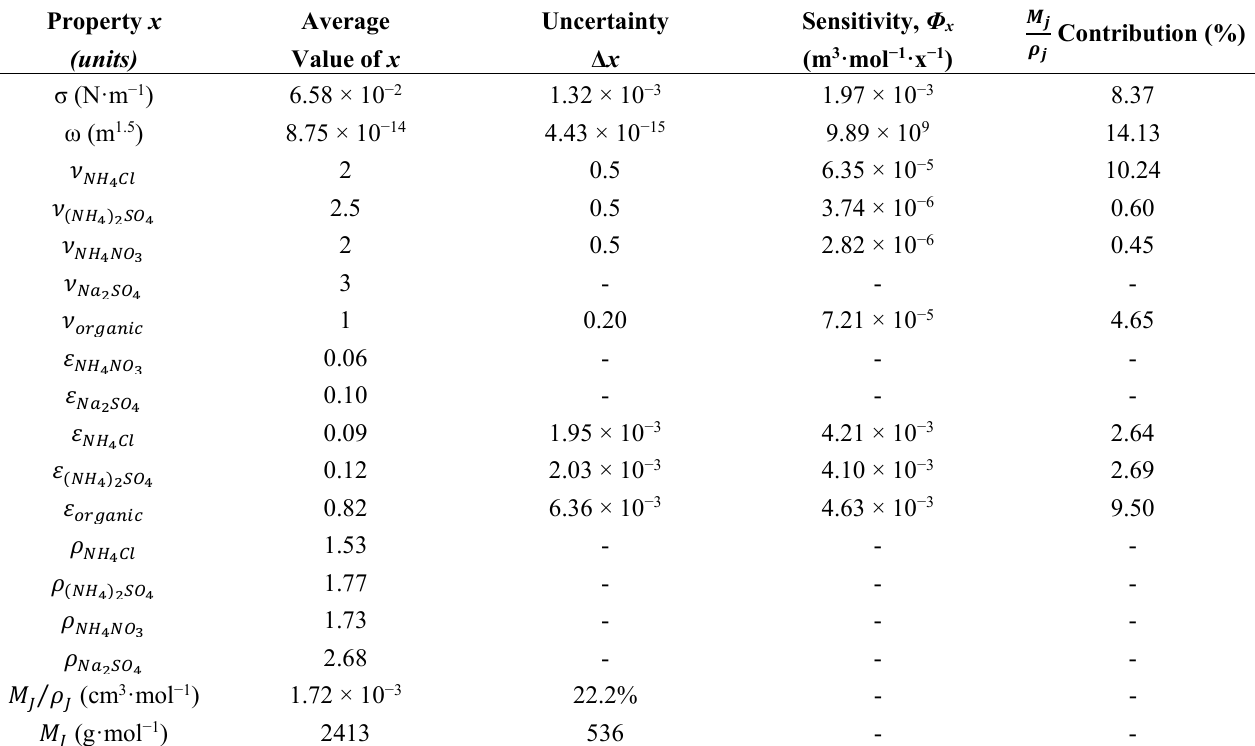
Table 4. Köhler Theory Analysis for Sub-Cloud (SC)